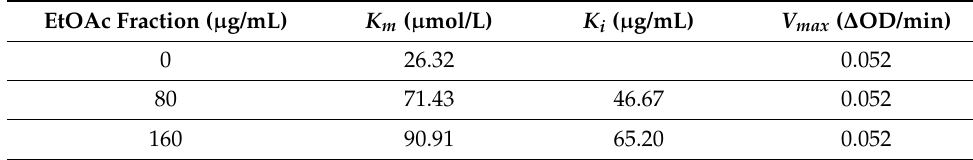
Table 1. The inhibitory kinetic parameters of the EtOAc fraction on XO.